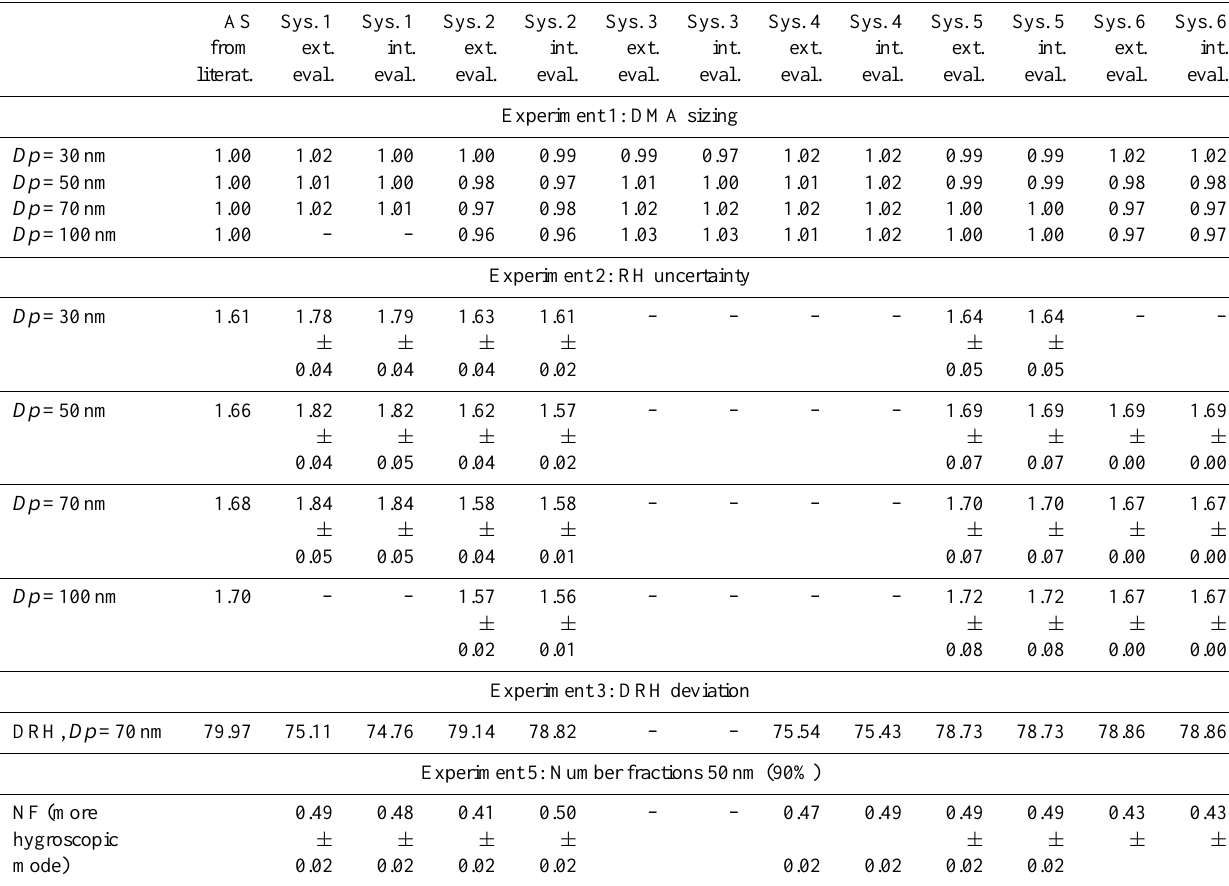
Table 3. Mean dry growth factors (DMA sizing of dry particles) (exp. 1), hygroscopic growth factors (exp. 2) ± 1std., deliquescence relative humidities (exp. 3) derived for ammonium sulphate particles based on internal and external data evaluation procedures and more hygroscopic number fractions derived for the externally mixed aerosol (exp. 5) ±